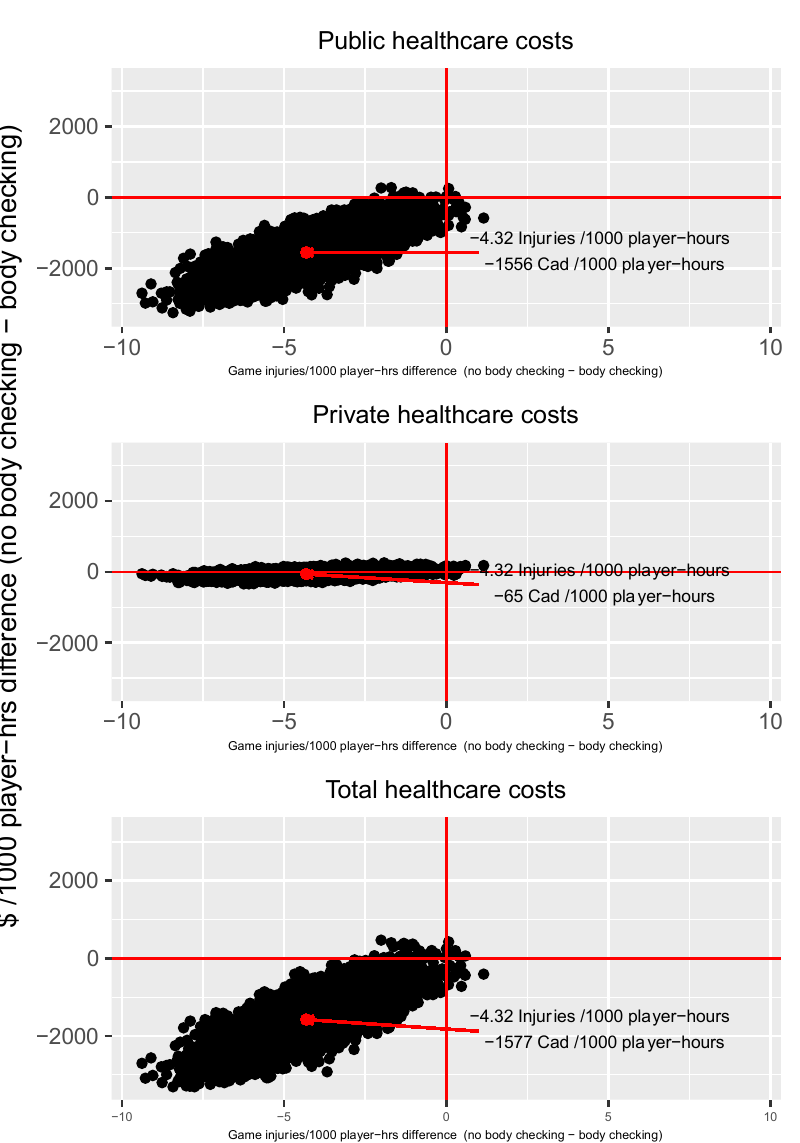
Figure 1. Probabilistic Sensitivity Analysis for policy comparison of body checking to no body checking.